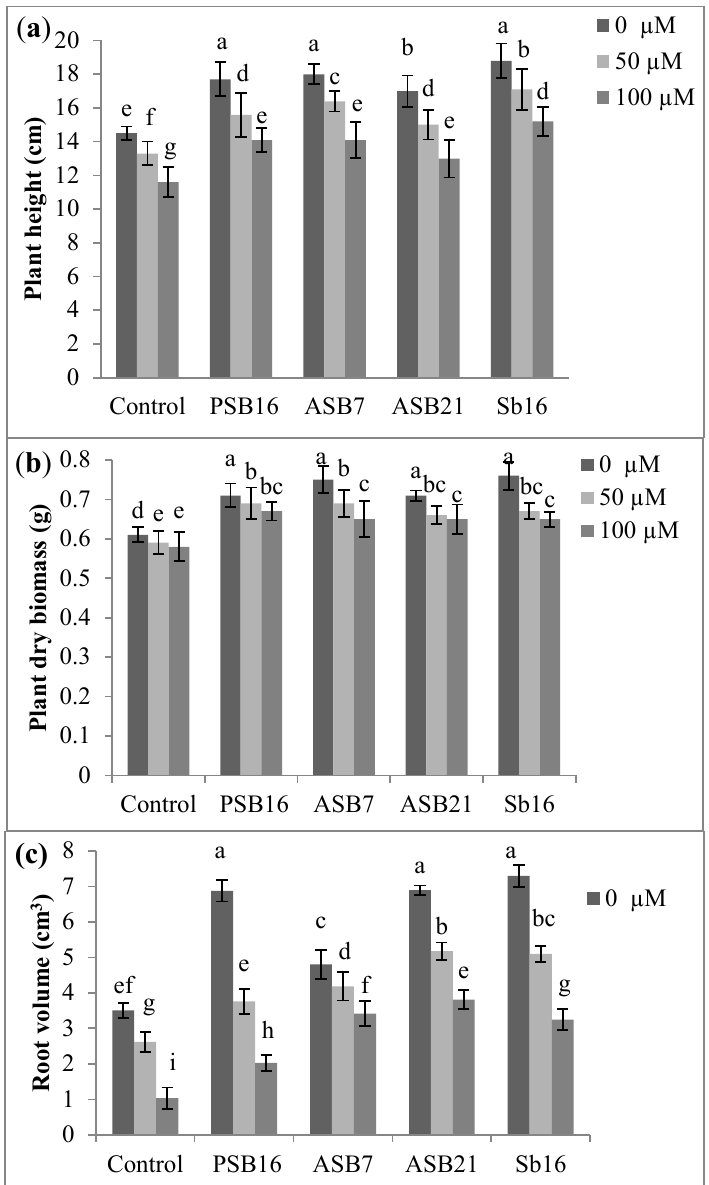
Figure 2. Effects of Al on the growth of rice seedlings inoculated with PGPB: ( a ) plant height; ( b ) plant dry biomass; and ( c ) root volume. Where, PSB 16 = Bacillus sp., Sb16 = Stenotrophomonas maltophila , ASB7 = Burkholderia thailandensis , ASB21 = Burkholderia seminalis . Means within the same column followed by the same letters are not significantly different at p < 0.05. Bars indicate standard error, n =